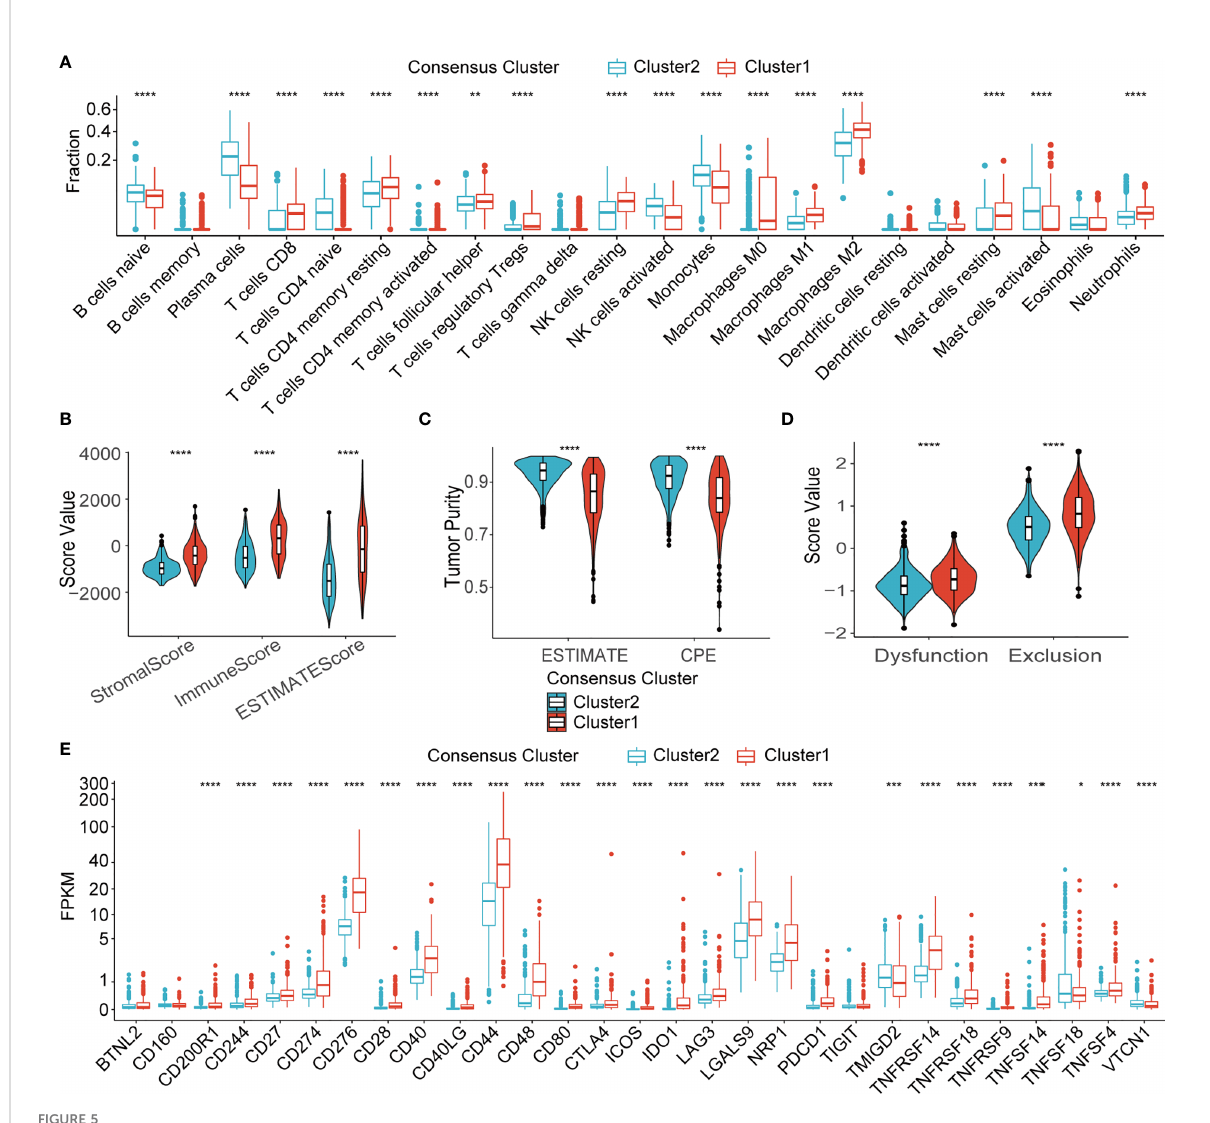
FIGURE 5 Immune microenvironment of two clusters. (A) Fraction of 22 types of immune in fi ltrating cells in Cibersortx in two clusters. (B) ESTIMATE score of two clusters. (C) Tumor purity estimation of two clusters using the ESTIMATE and the CPE algorithms (D) T cell dysfunction score and T cell exclusion score of two clusters. (E) mRNA expression of 29 ICPs in two clusters. TCGA, The Cancer Genome Atlas; NK, natural killer; ESTIMATE, Estimation of STromal and Immune cells in MAlignant Tumor tissues using Expression data; CPE, consensus measurement of purity estimations. *P < 0.05; **P < 0.01; ***P < 0.001; ****P <